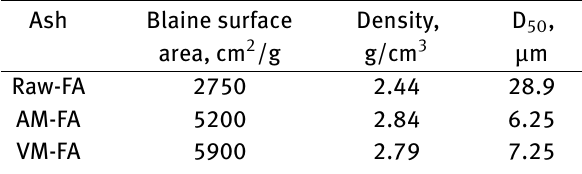
Table 2: Physical properties change of milled fly ashes Ash Blaine surface Density, area, cm 2 /g